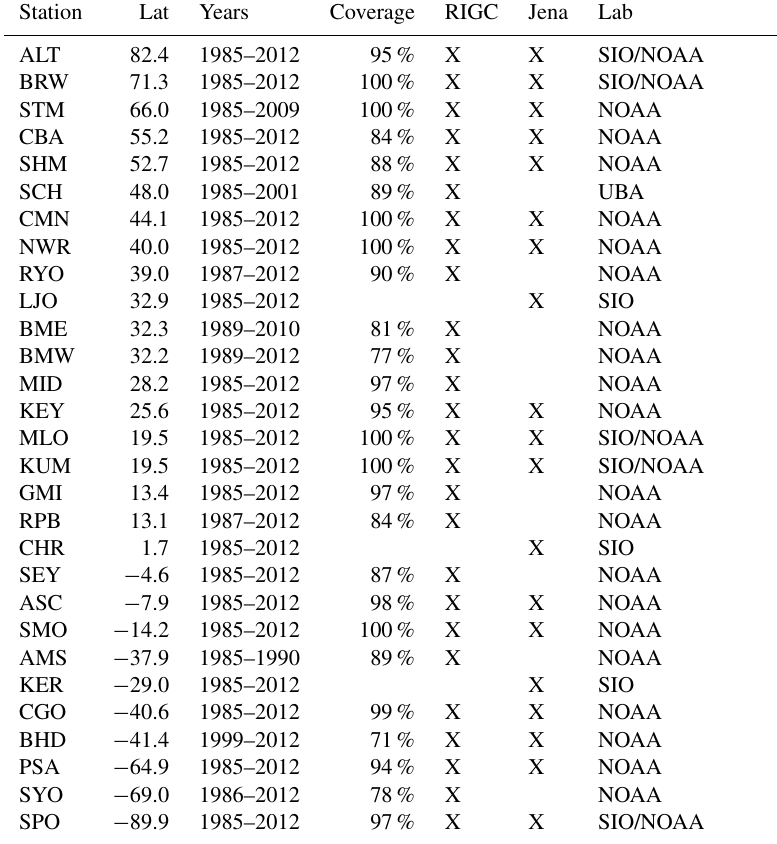
Table 1. CO 2 observation stations included in each